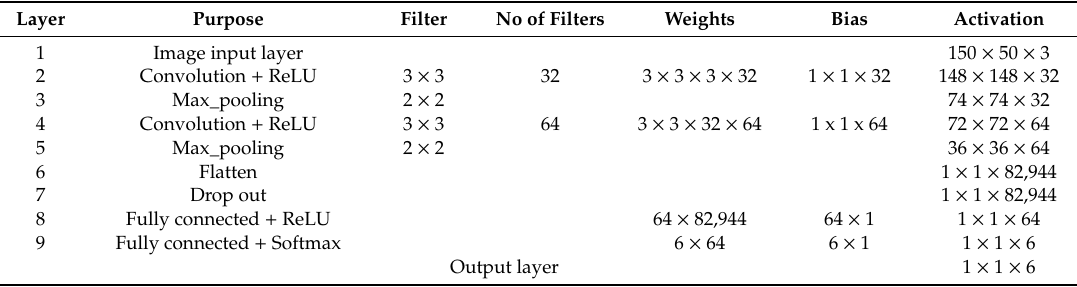
Table 1. An architecture of the CNN model for fruit